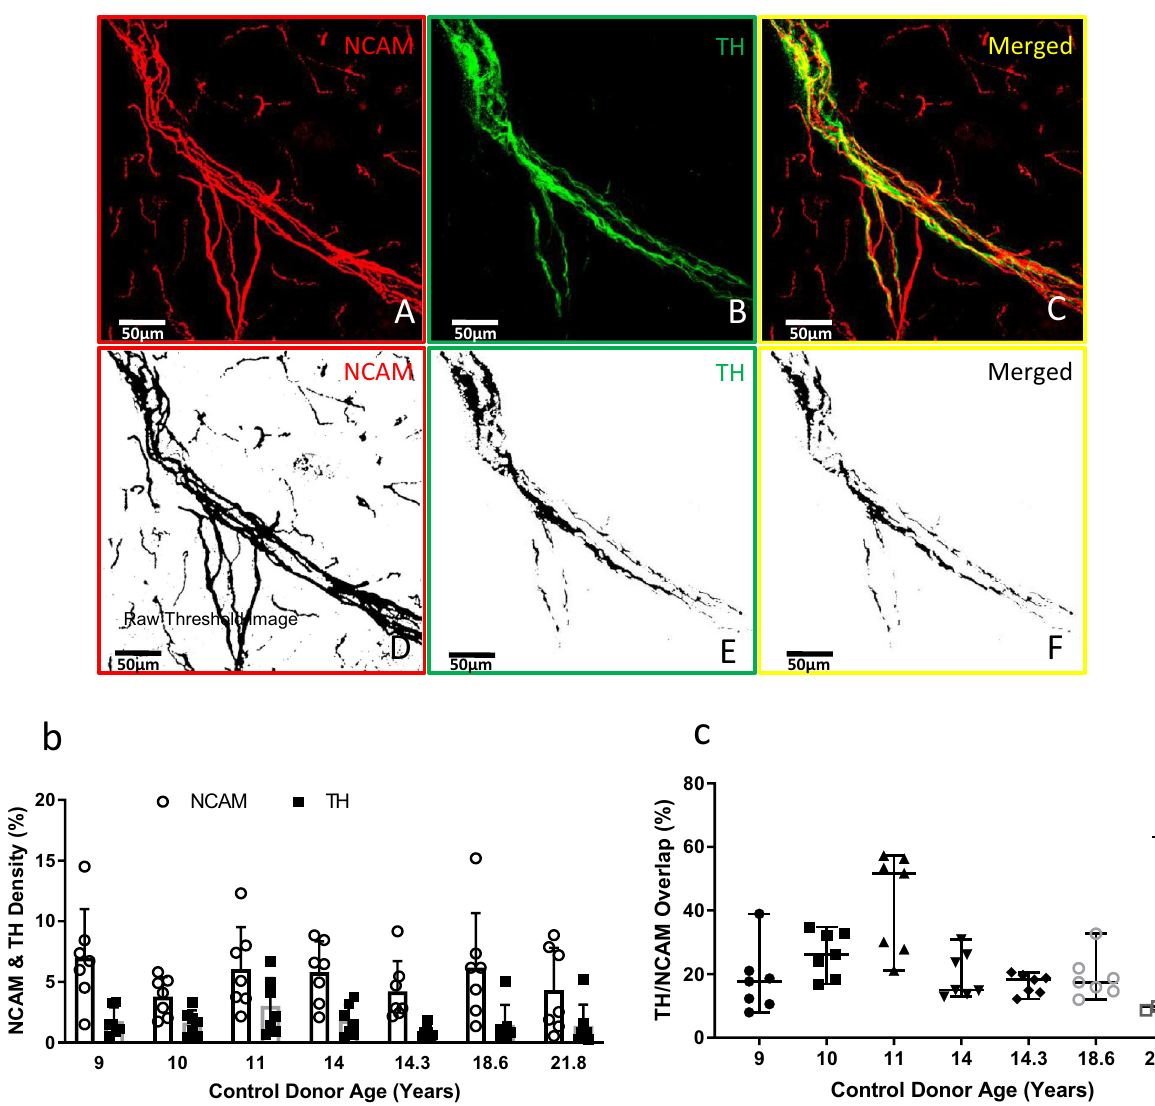
Figure 2. Islet NCAM and TH axon image analysis by confocal microscopy and ImageJ in control donors. Frozen sections (40 µm thick) were fixed and stained for neural cell adhesion marker (NCAM), tyrosine hydroxylase (TH) and glucagon (α-cells, see Fig. 3a) to define total and sympathetic innervation and islets, respectively, as described in Methods. Islets were contoured on maximum intensity projects as demonstrated in ( a ). ( a ) The z-stack confocal images of 40 µm thick sections stained for NCAM and TH were converted into MIP images (A) NCAM in red, (B) TH in green and (C) merged image representing colocalization NCAM and TH. The images D, E, F are the corresponding threshold images to (A), (B) and (C) respectively. These raw threshold images were quantified for % density per unit area for NCAM and TH within islets. ( b ) The thresholded images were quantified for NCAM and TH density (%). ( c ) The thresholded images were quantified for TH/NCAM overlap (%). Data are scatterplots with bars representing mean ± SD for 7 islets/donor in 7 control donors, aged 9–21.8 years old. See also Supplementary Fig.